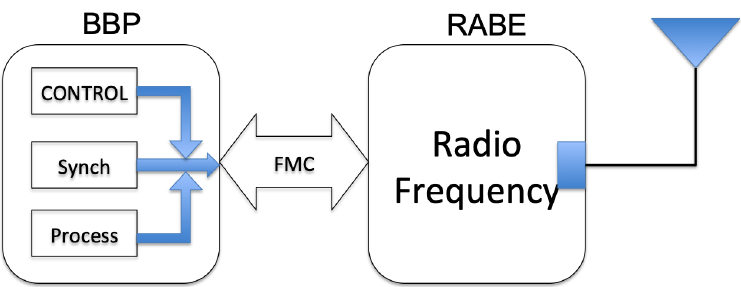
Figure 1. Communication system model. A block sequence about the communication system model and its architecture.